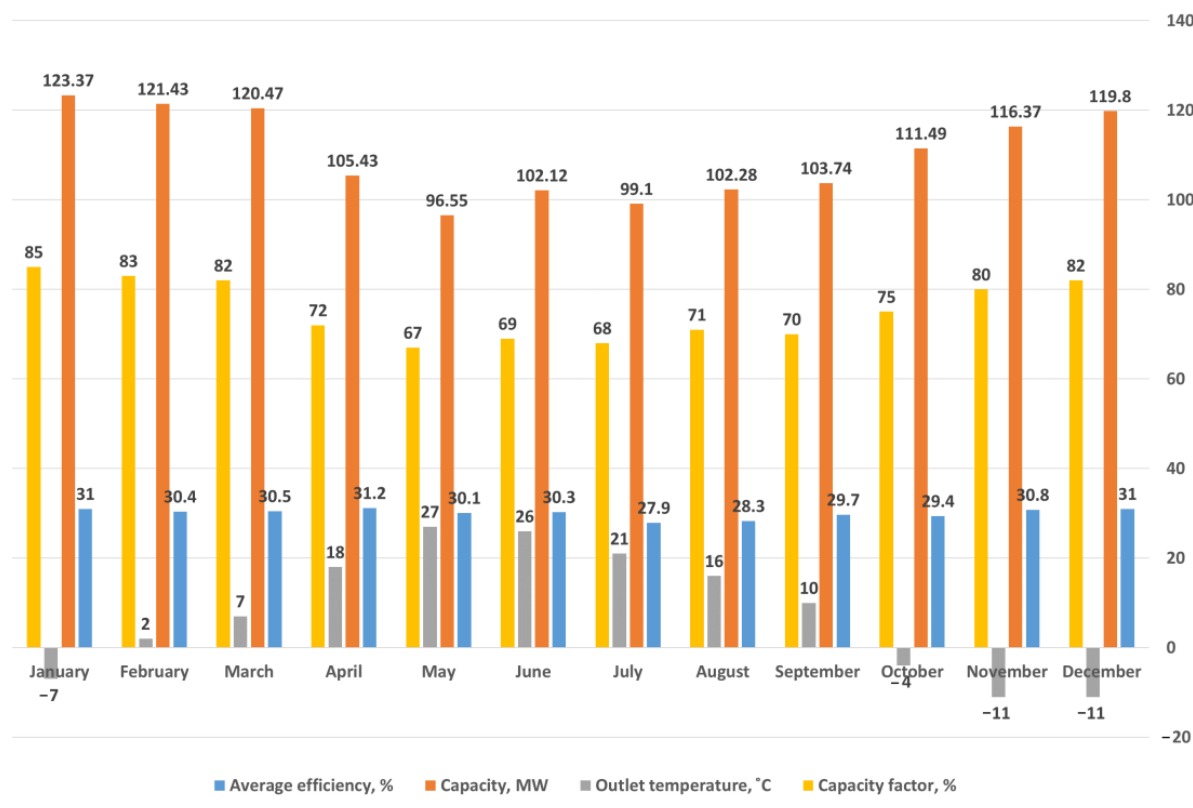
Figure 1. Dependence of GTPP and GTU parameters on ambient air temperature.